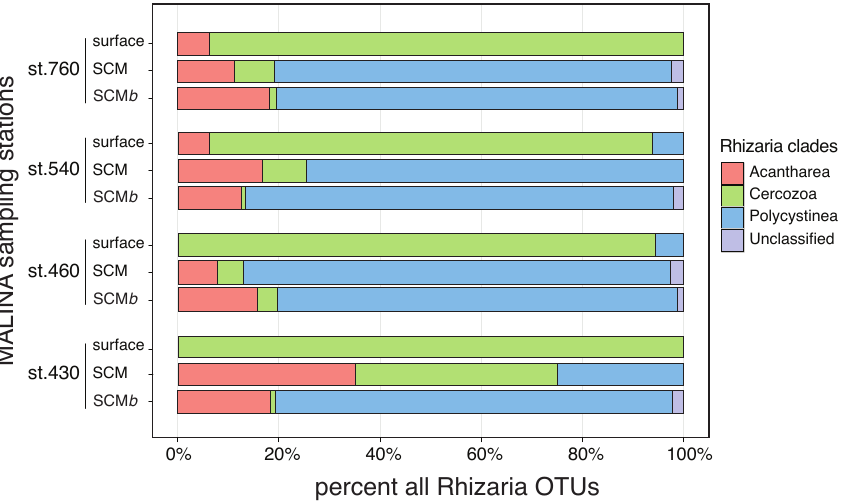
Fig. 3. Overall Rhizaria OTU distributions across Beaufort Sea samples. OTUs (clustered at ≥ 98% sequence identity) were taxonomically classified using an in-house curated sequence database based on NCBI taxonomy. The distributions of each sample in distinct Rhizaria clades are displayed according to the color legend.